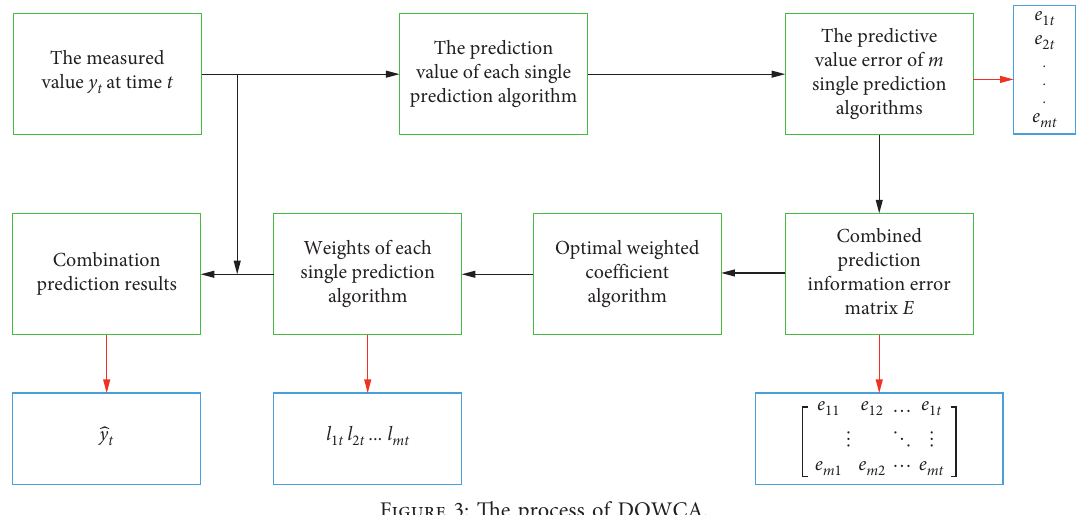
Figure 3: The process of